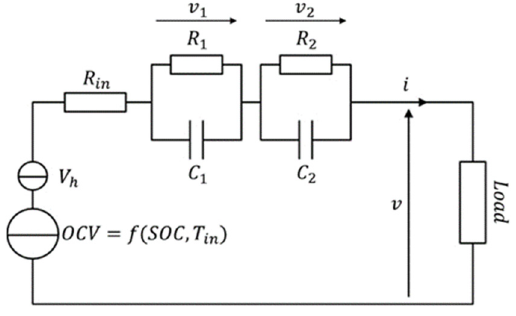
Figure 1. Battery electric circuit model.